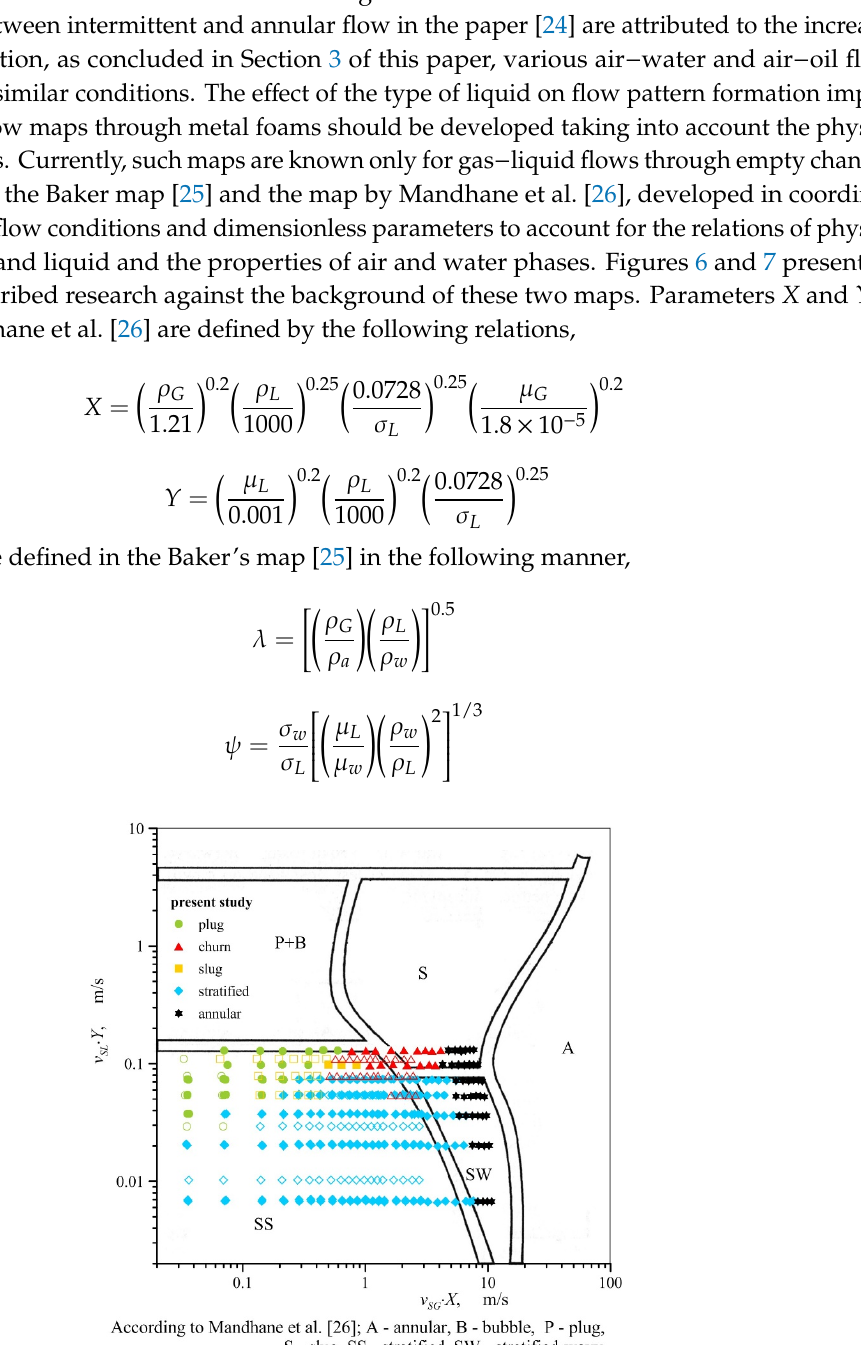
Figure 6. Ranges of pattern formation during gas − liquid flow through channels with metal foam packings vs. map developed by Mandhane et al. [26] (empty symbols refer to air − oil flow).